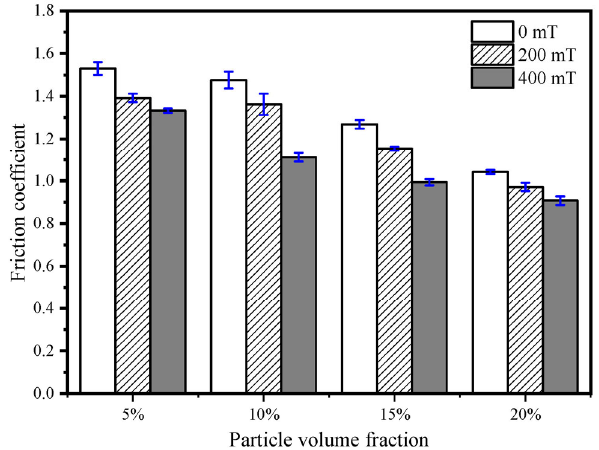
Fig. 16 Frictional coefficient of MRE with different volume fractions under different magnetic fields.